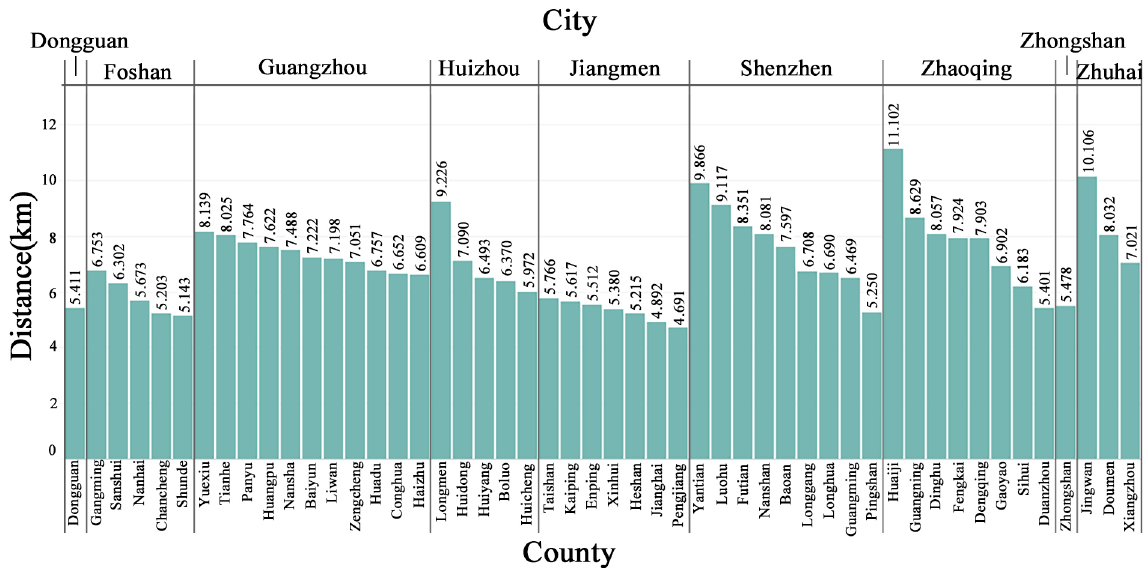
Figure 4 . The spatial distribution of counts and distances of population flows at the 500- m grid level in the PRD.